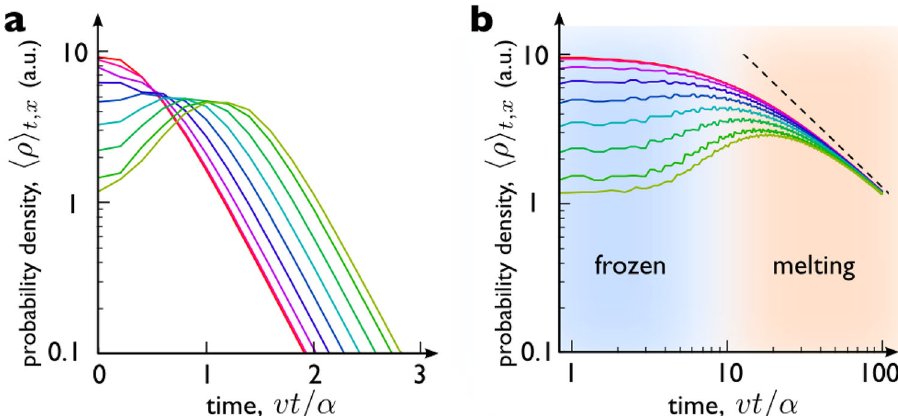
Fig. 2 Frozen regime and subsequent power-law decay in the melting regime. a Log-linear plot of dynamical evolution of postquench probability density 〈 ρ 〉 m α /( _ v ) = 0.1. This exhibits a fast exponential decay as displayed by the linear slope, with probability density t , x for small dimensionless mass attenuating rapidly. b Log – Log plot of postquench probability density 〈 ρ 〉 t , x for large m α /( _ v ) = 20. In contrast to a , this exhibits a very slow decay and has a evolution characterized by two distinct regimes: (blue shaded) a slow frozen regime where probability density hardly evolves, and (orange shaded) a power law melting regime where the probability density decays temporally as t − 1 (indicated by dashed line). For both panels, curves from top to bottom (red to green) indicate various positions away from the domain wall x / α = 0 → 1.2 in steps of 0.15. The probability density was obtained from direct numerical integration of Eq. (4) using the initial boundary mode pro fi le Φ ( x ) = sech( x / α